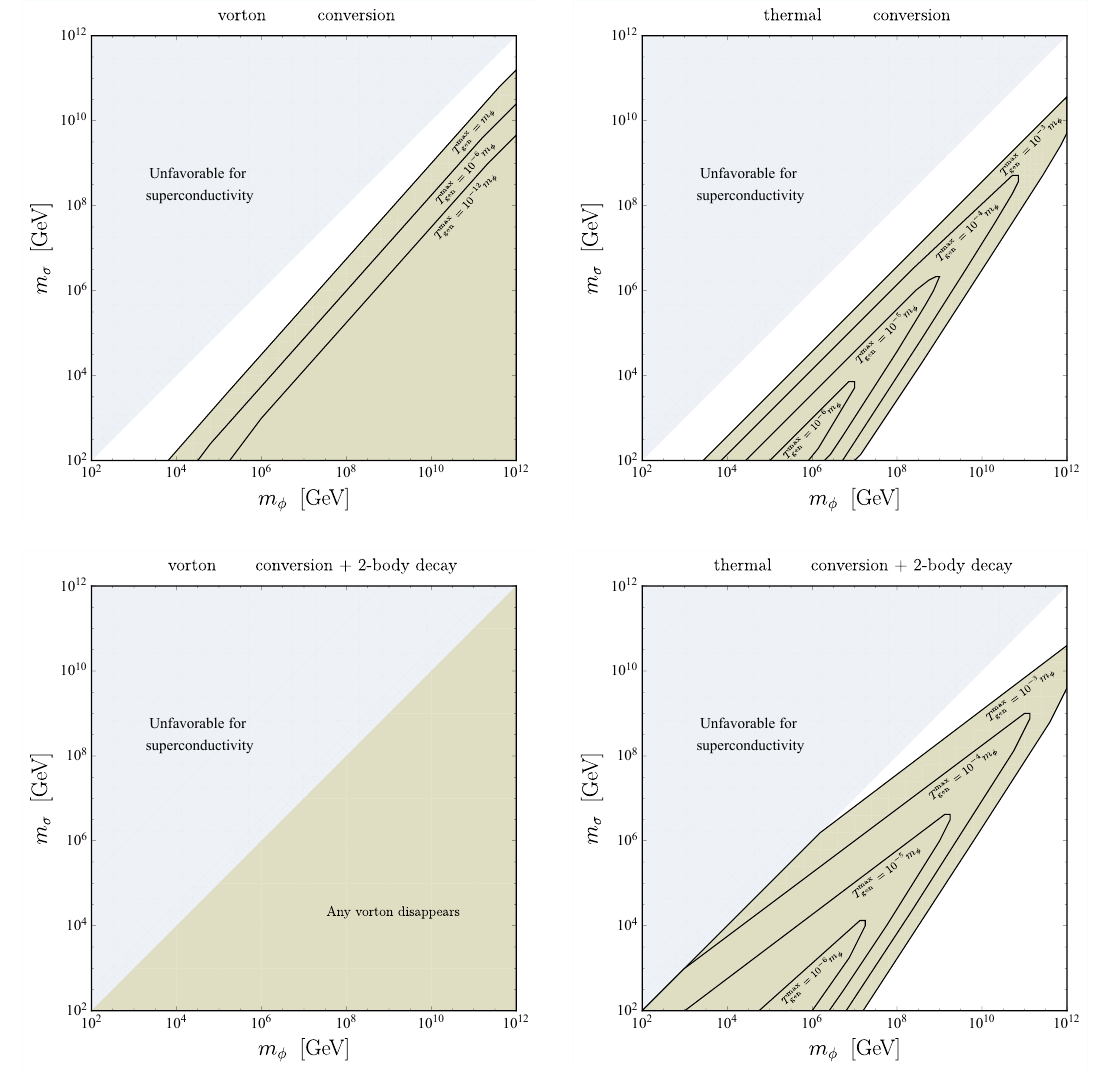
Figure 11 . The parameter spaces for ( m σ , m φ ) where the vortons are dead by now. We set E = m φ . The black contours in the colored regions indicate the values of T max maximum T among the living vortons in the present Universe. In the white blank regions, all gen vortons survive in the present Universe. These figures differ with respect to the type of string curves and decay processes as indicated. The upper-left gray regions in the plots are unpreferable to the